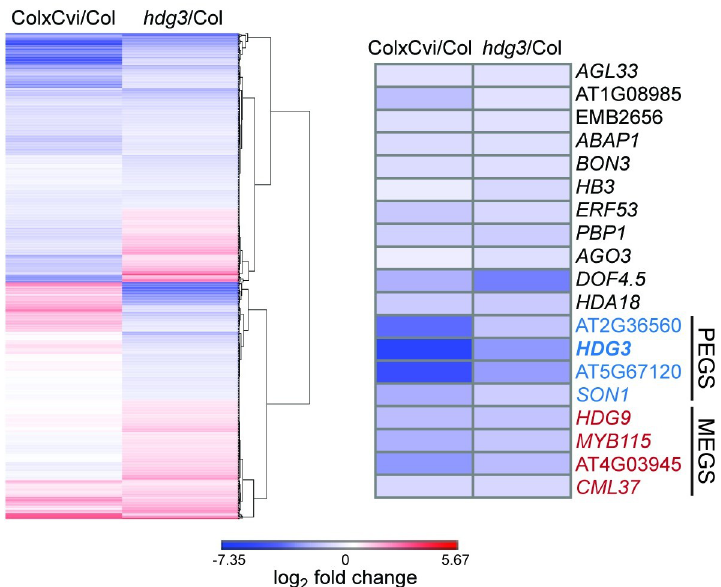
Fig 3. Transcriptional effects associated with low HDG3 expression. (left panel) Genes downregulated in hdg3 mutant endosperm also have reduced expression in Col x Cvi endosperm compared to Col. The plot shows the expression profile of genes with significantly altered expression in hdg3-1 endosperm (p < 0.05). Genes were hierarchically clustered by Euclidean distance and complete linkage using Gene-E. (right panel) A subset of putative developmental regulators with reduced expression in hdg3 and Col x Cvi